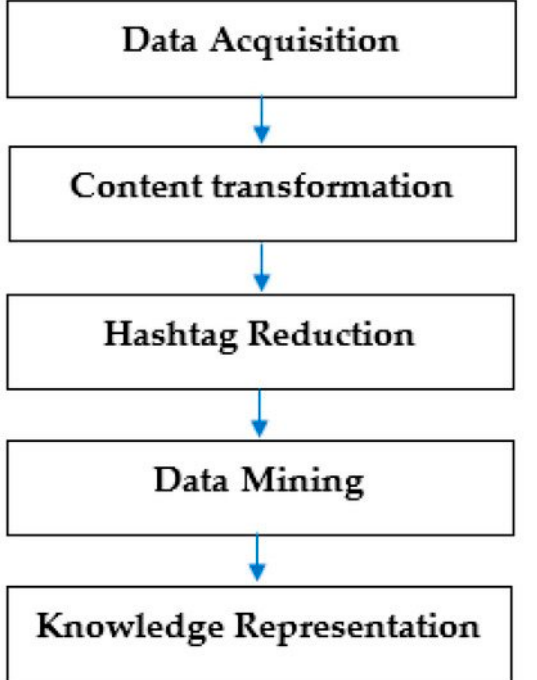
Figure 1. Process of Social Media Analysis using the SMAHR Framework. (1) Data acquisition: The Twitter API [77] was used to extract messages (Tweets) from the Twitter network. Tweets were collected in the time period between 30 May 2017 and 30 May 2022 (a 5-year period). In total, 686,450 Tweets with the hashtag #foodblogger were captured from 171,243 unique users by the Python script [78] during that